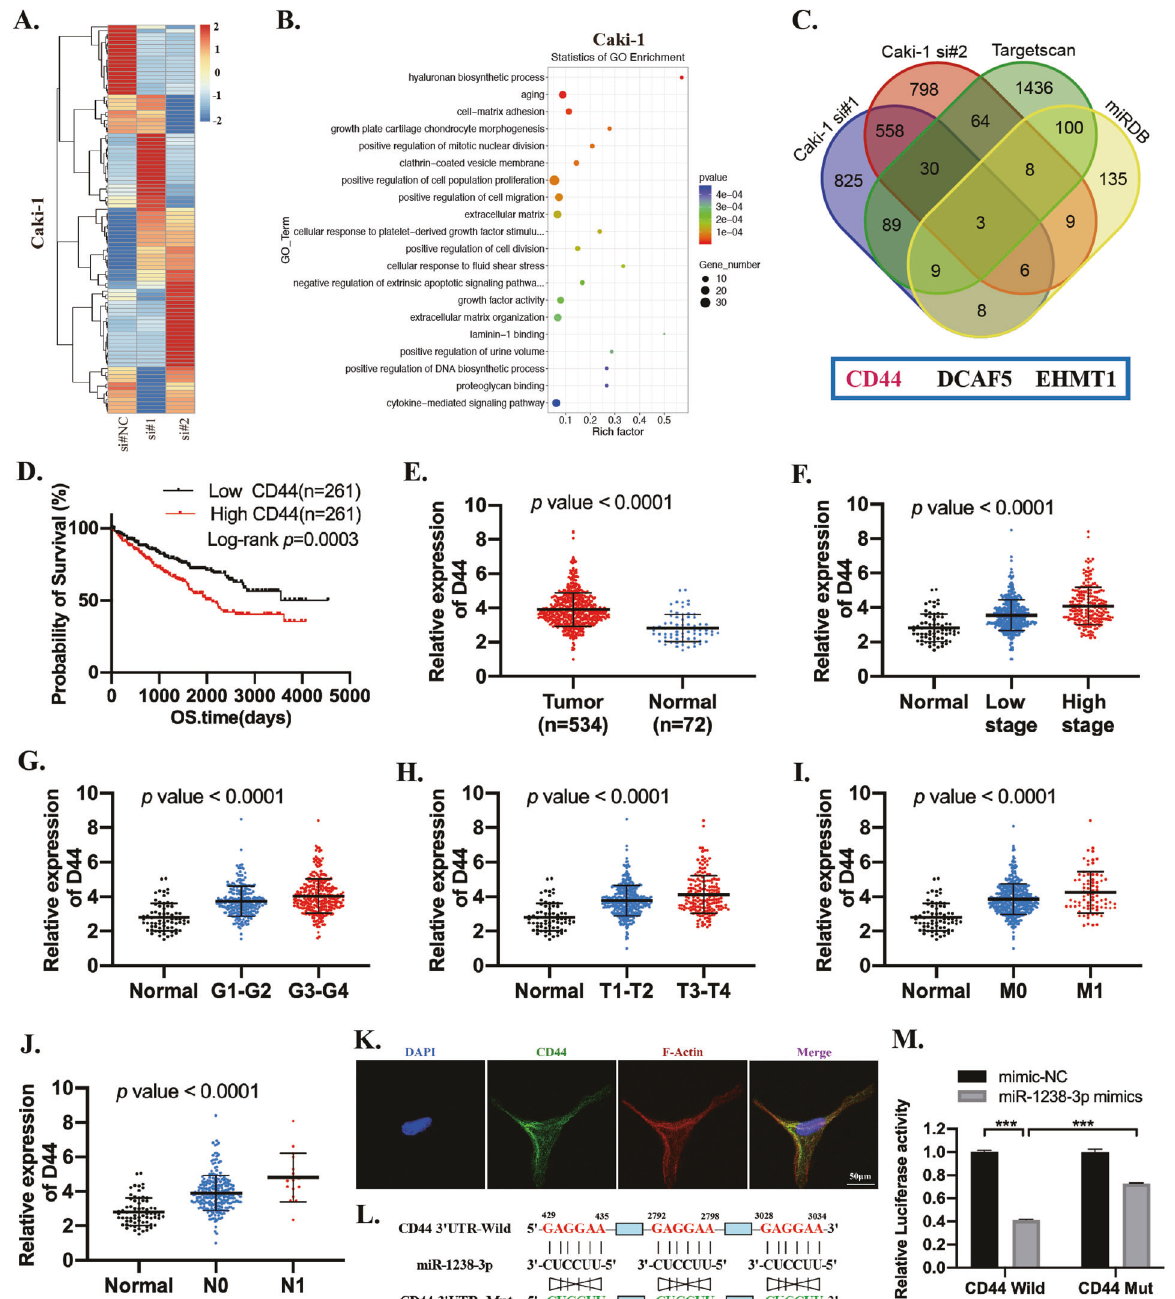
Fig. 6 The identi fi cation and clinical characteristics of CD44 in ccRCC. A Heatmap for the differentially expressed genes in circPPP6R3- knockdown Caki-1 cells. B GO analysis was performed for the differentially expressed genes. C Venn diagram was performed to screen the potential targets of miR-1238-3p by MiRPathDB, Targetscan and RNA-seq. D Kaplan – Meier analysis indicated that high expression of CD44 predicted poor survival probability. E Expression of CD44 in ccRCC based on TCGA samples. F – J Relative expression of CD44 in ccRCC with different clinical stages, pathological grades, T stages, M stages, and N stages from TCGA. K Representative IF images of ACHN cells stained with CD44 were shown. L Sequence of CD44 3'UTR binding to miR-1238-3p, predicted by Targetscan, and relative mutated sequence were shown. (Totally three predicted binding sites were mutated). M Dual-luciferase reporter assay was performed in 293T cells to determine the interacting relationship between miR-1238-3p and